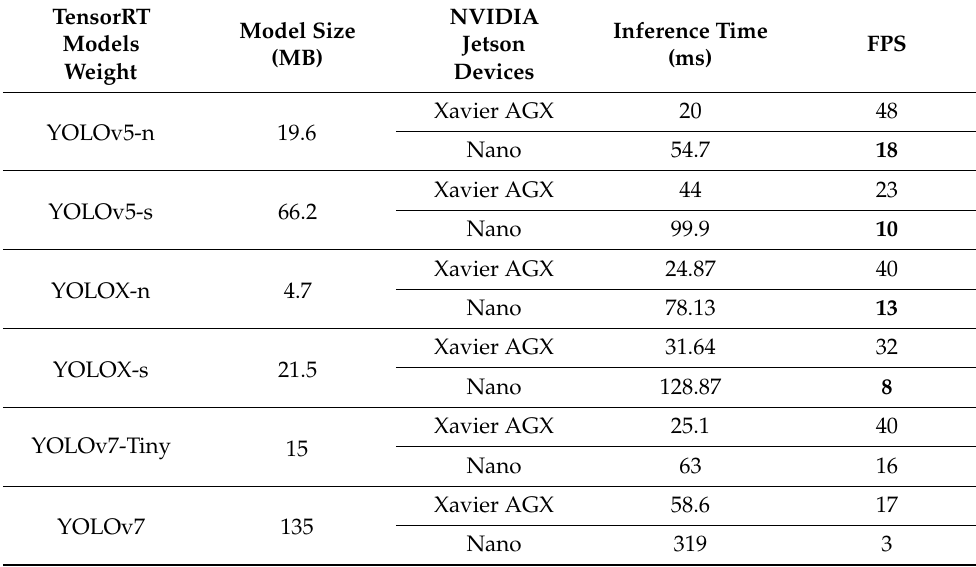
Table 6. Comparison of different YOLO-TensorRT models in term of size storage and inference time on NVIDIA Jetson